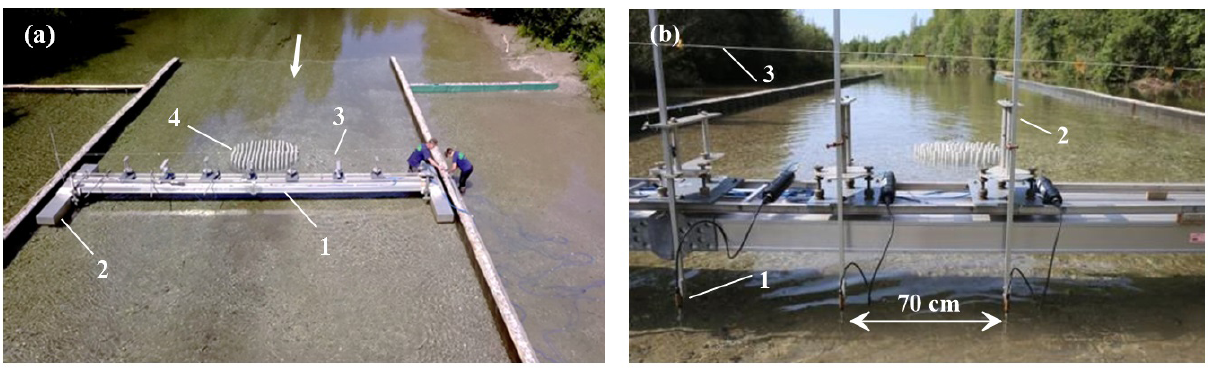
Figure 4. Measuring frame and setup: (a) floatable platform (1 is a lateral platform, 2 is a float, 3 is a deployment mount, 4 is a porous emerged obstruction and the white arrow shows flow direction) and (b) instrumental setup (1 is a velocimeter sensor, 2 is a deployment bar and 3 is an orientation